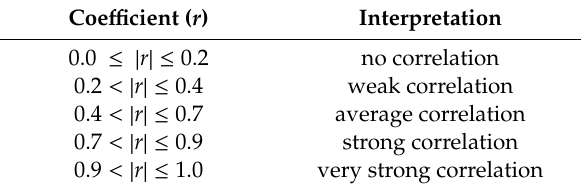
Table 1. The Pearson correlation coe ffi cients used in the case of statistical significance 1 .